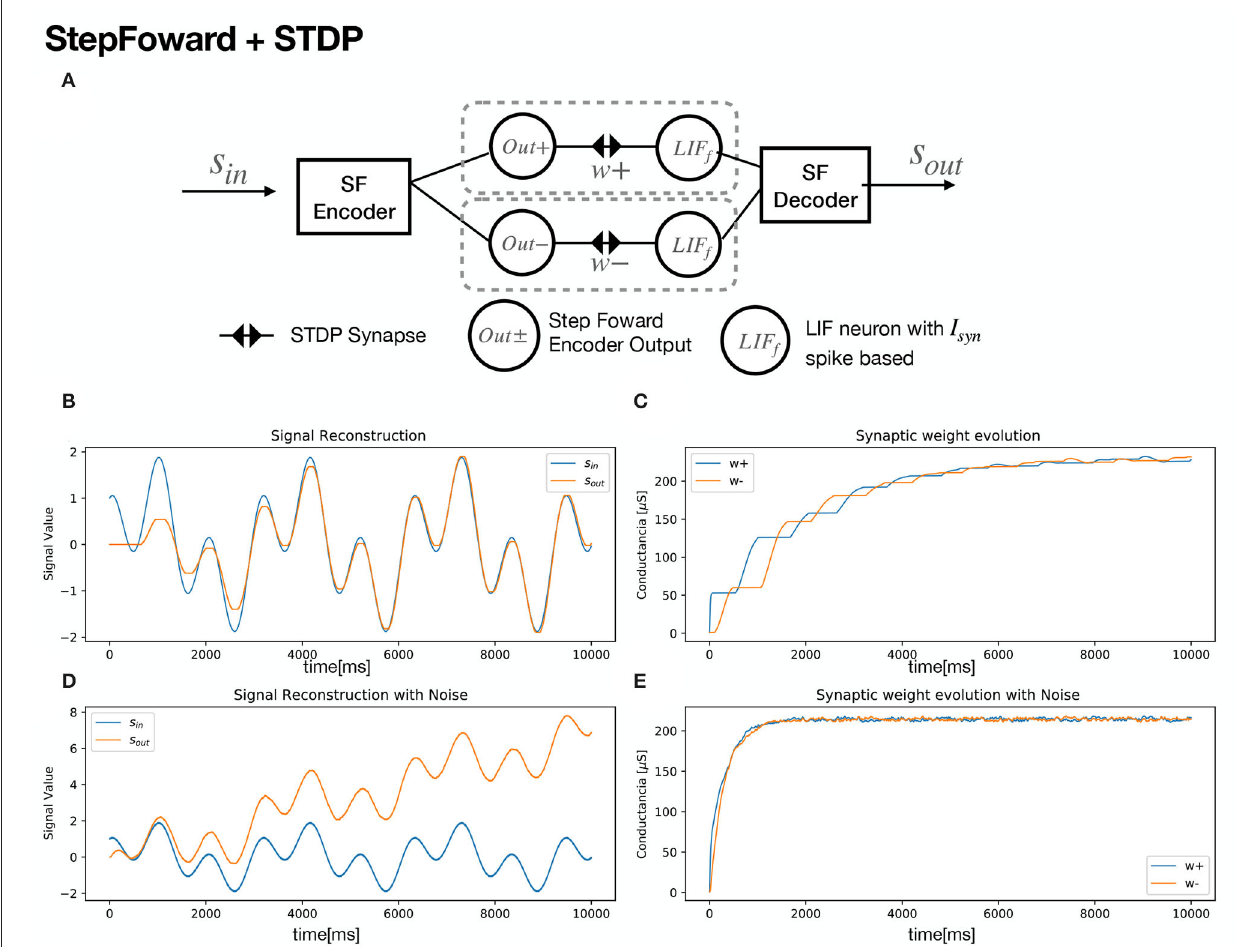
FIGURE 2 | Step Forward + STDP Neural structure. (A) Schematic of the structure. (B) Sinusoidal Signal s in = sin( ω t ) + cos(3 ω t ) being reconstructed. (C) Synaptic Weight evolution. (D) Gaussian noise with σ = 0.01 was added to foster synaptic update. (E) Synaptic Weight evolution with added noise. Simulation Parameters are available at Table 2 .